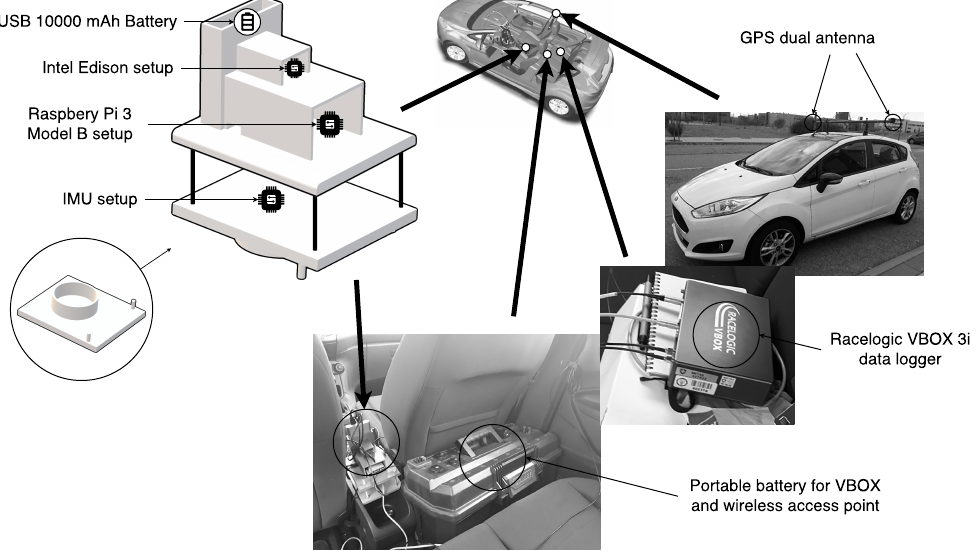
Figure 1. Test vehicle equipped with different low-cost systems, VBOX data logger, 3 IMU sensors and GPS